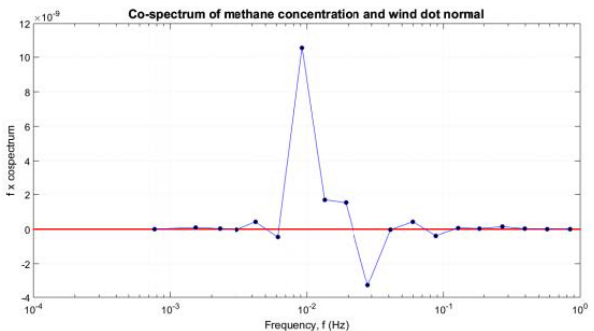
Figure 4. Average cospectrum of the outward-directed compo- nent of the observed wind and the methane concentration from 70 laps around a point source near San Antonio, Texas. The peak at 10 − 2 Hz corresponds to the period of the